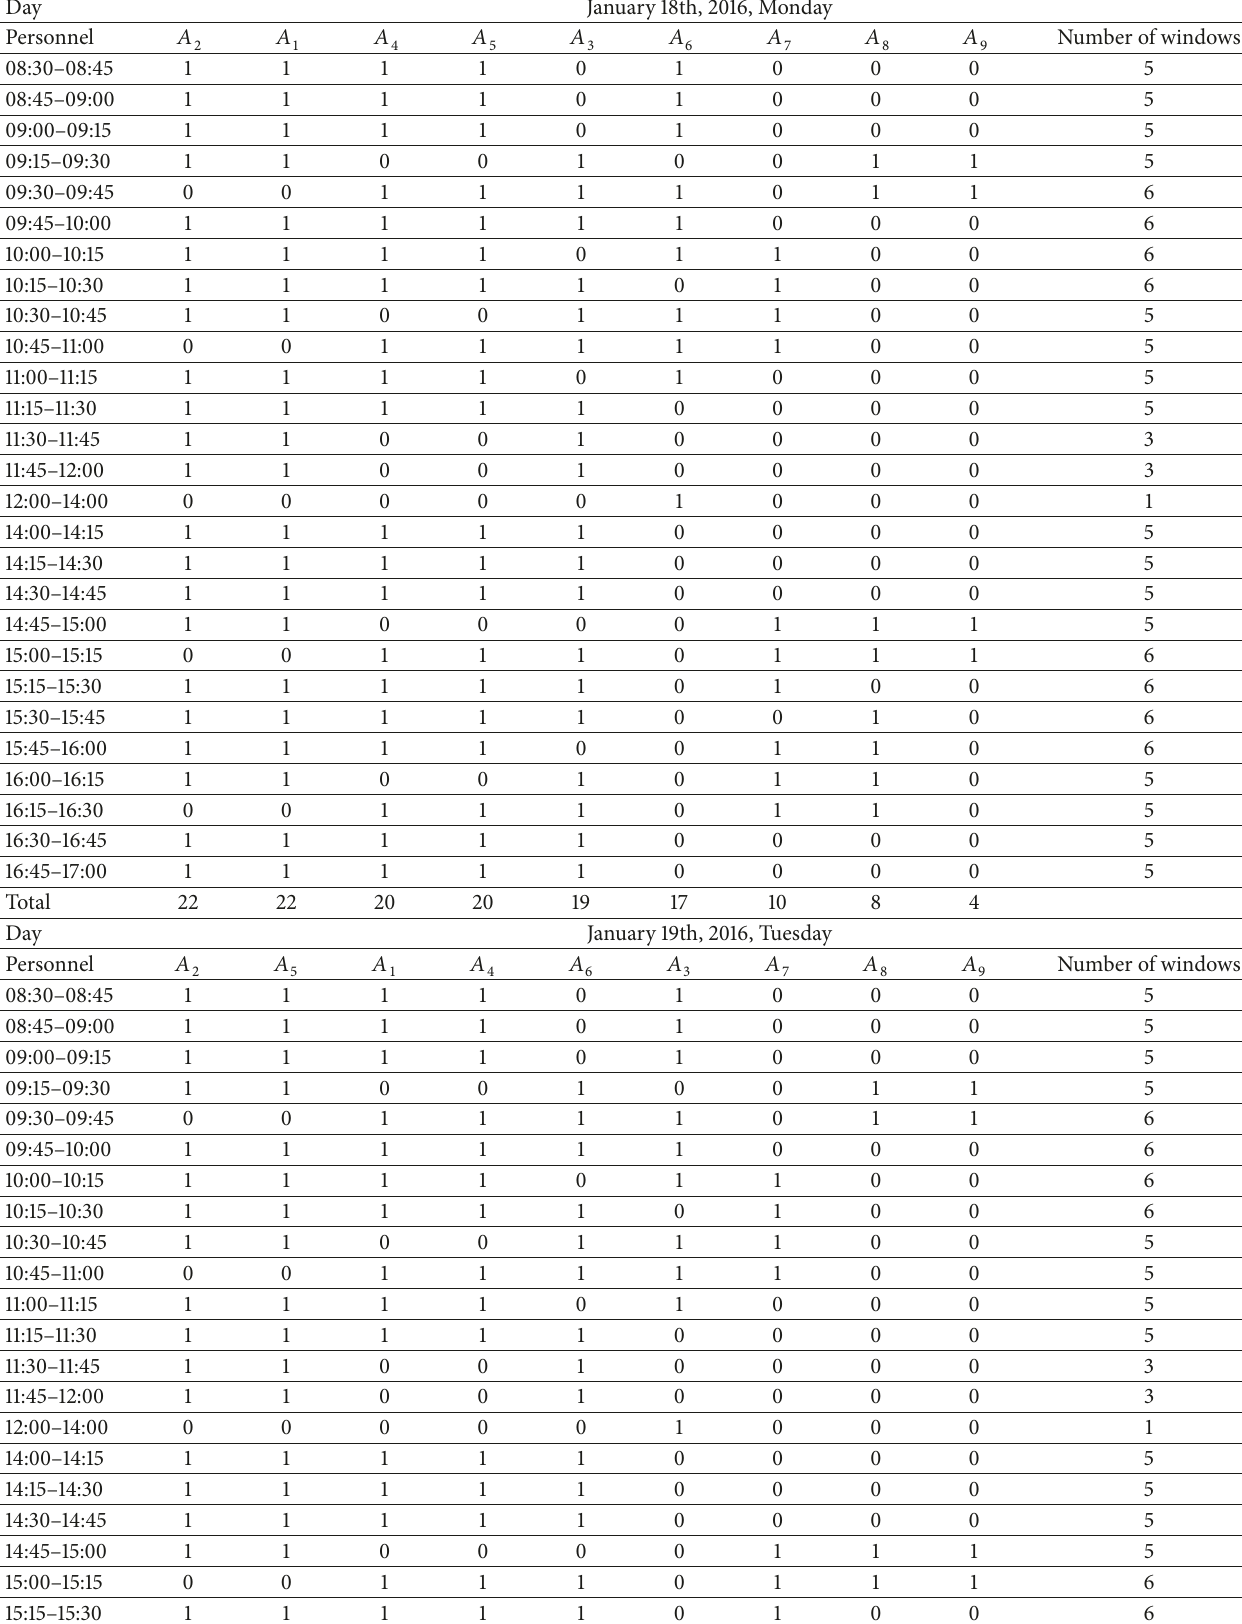
Table 3: Flexible scheduling of the window